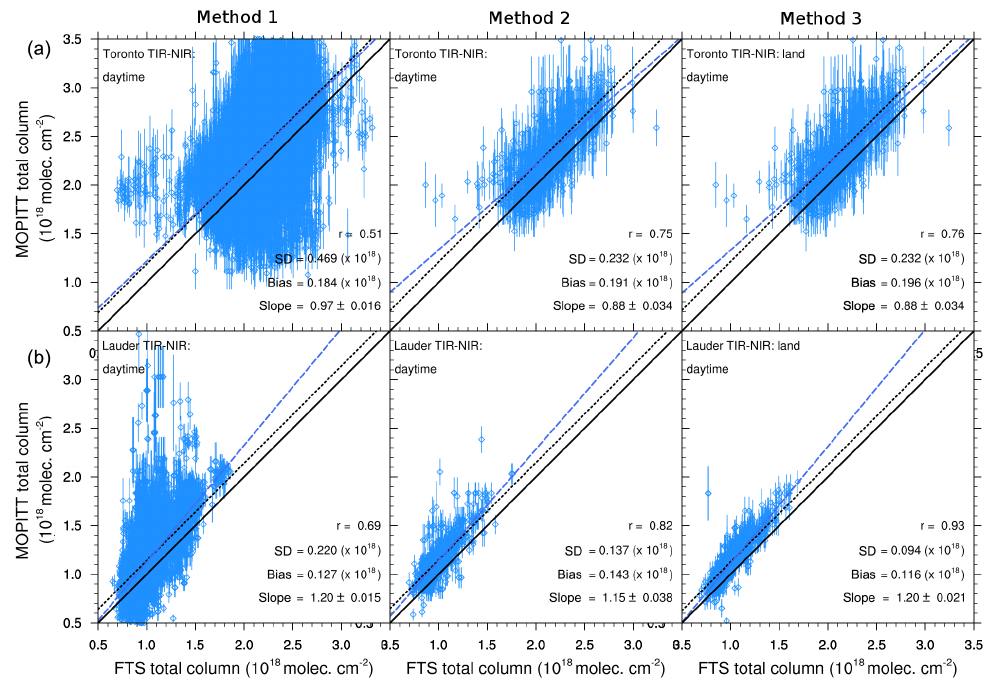
Figure B1. Example of correlation plots for validation methods 1 to 3 for V6 TIR–NIR product at Toronto (a) and Lauder (b) . Methods are arranged in columns. The blue dashed line indicates the cor- relation slope, the black dashed line indicates mean bias, and the solid black line is the 1 : 1 line for comparison. Error bars are the MOPITT error.